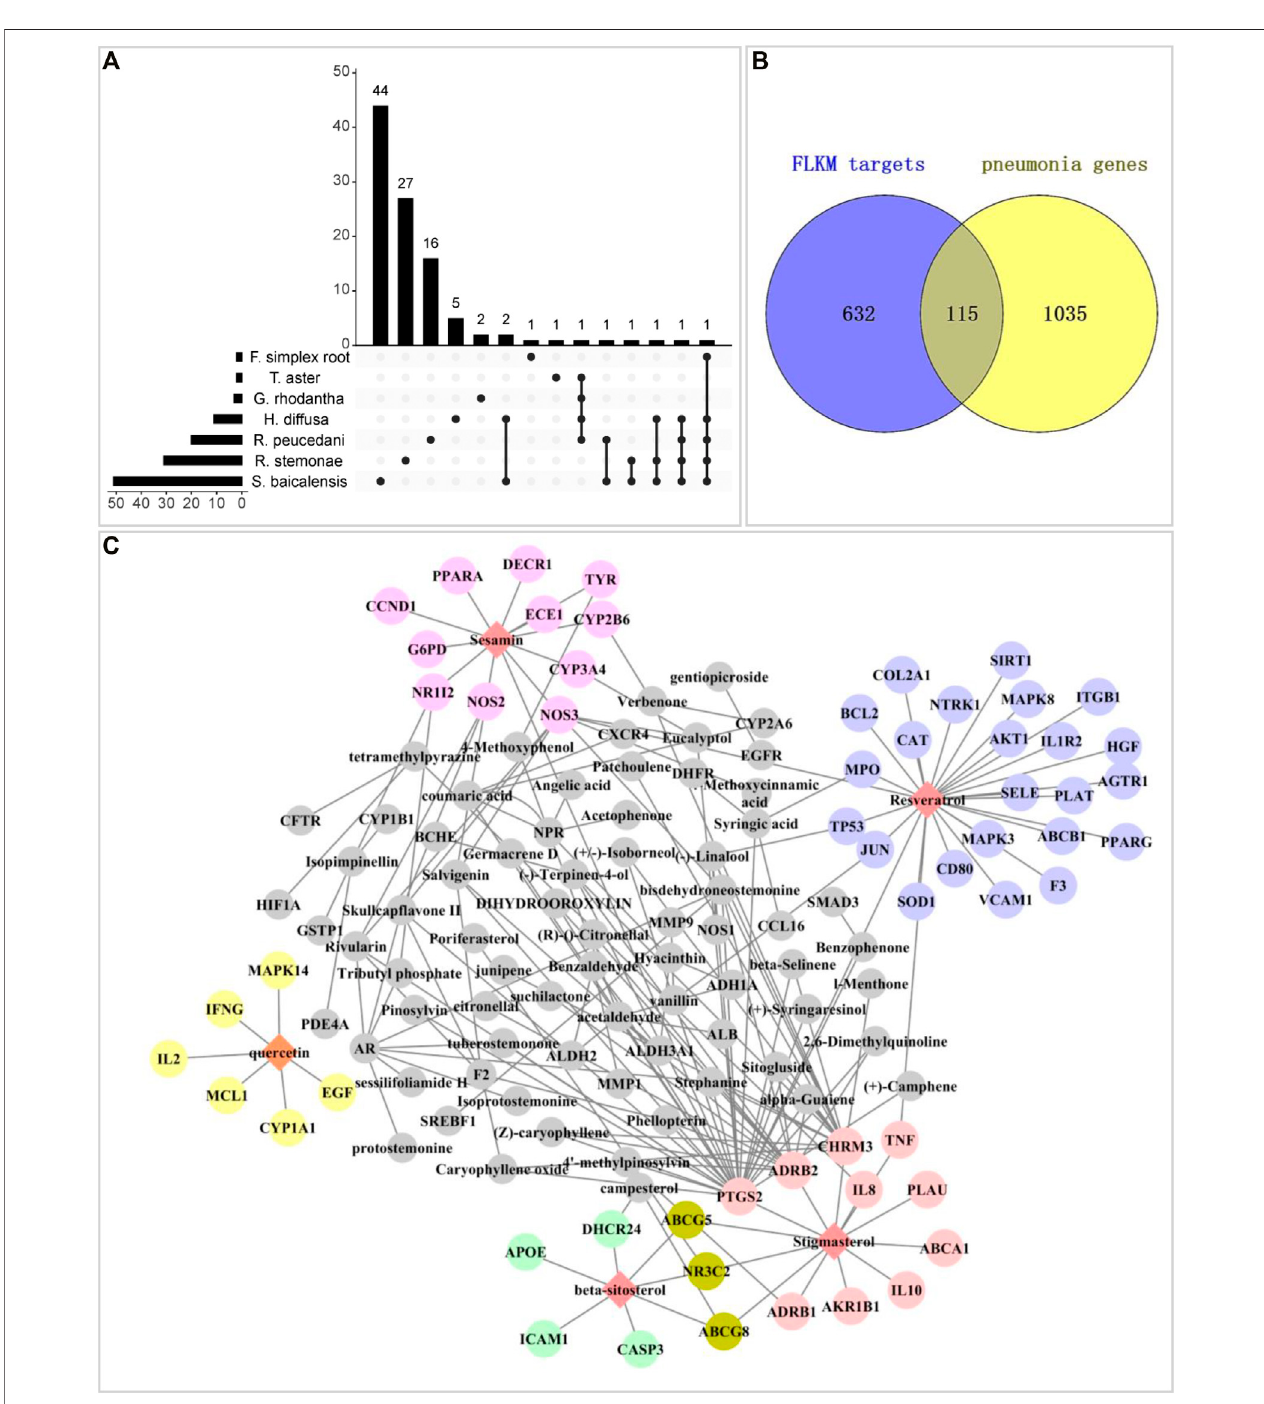
FIGURE 2 | (A) The intersection diagram of components in FLKM for the seven botanical drugs. The horizontal histogram shows the number of components of each botanical drug, while the vertical histogram shows the size of different intersections of these seven botanical drugs sets. (B) The 115 intersecting targets of FLKM and pneumonia were identi fi ed via a Venn diagram. (C) The component - target (CT) network diagram was visualized using the Cytoscape software. The colorful node represent the important compounds of resveratrol, stigmasterol, beta-sitosterol, sesamin and quercetin and their directly related targets. The gray node represent the other compounds and their directly related targets The lines among inner nodes display the relationship between different nodes.